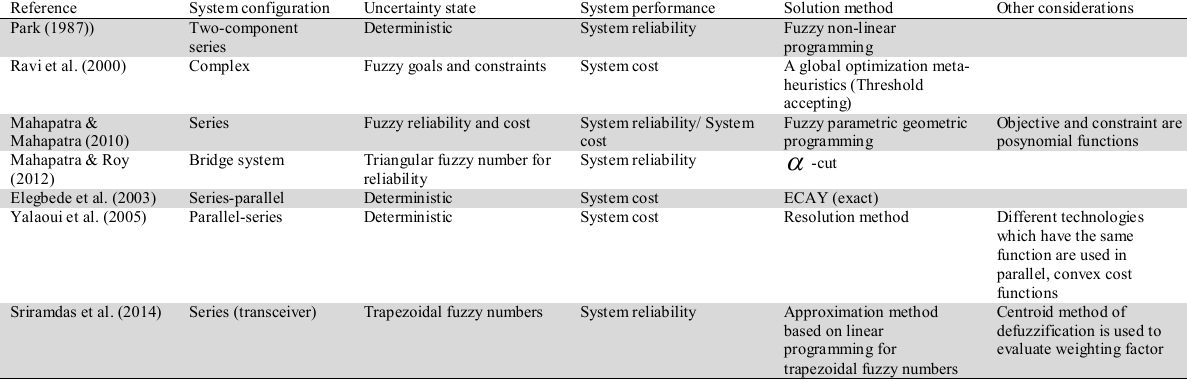
Reliability allocation (Single Objective